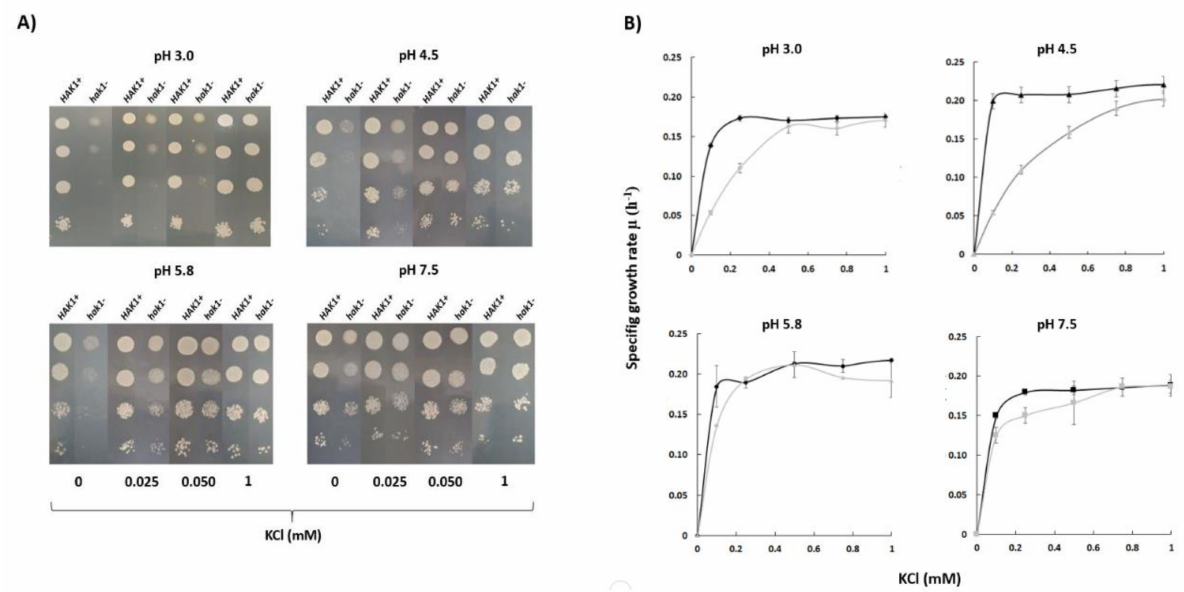
Figure 2. Potassium requirements for growth at different pHs in C. albicans HAK1+ and hak1 − strain. ( A ) Serial dilutions of yeast suspensions were inoculated on YNB-F plates containing the indicated concentrations of KCl and adjusted at the required pH as described in the Materials and Methods. The pictures were taken after 48 h incubation at 28 ◦ C. Drop tests were repeated three times and a representative experiment is shown. ( B ) Specific growth rate of C. albicans HAK1+ (Black) and hak1 − (Gray) at different K + concentrations in liquid YNB-F medium supplemented with the indicated amounts of KCl and adjusted at the required pH as described in the Materials and Methods. Cultures were inoculated at A 600 0.05, growth was monitored during 48 h, and specific growth rates were deduced from data in growth curves. Mean values ± standard deviation obtained in three independent experiments are